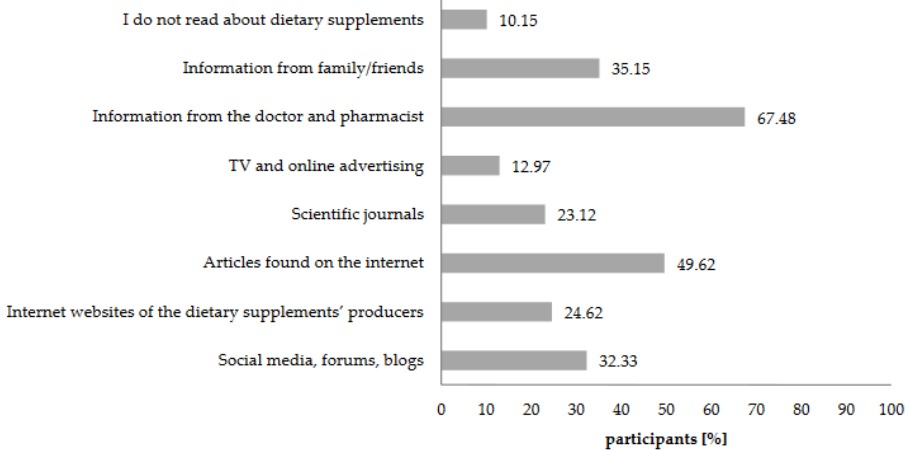
Figure 2. Sources of consumers’ knowledge on the subject of dietary supplements. Values do not add up to 100%, because more than one answer was allowed.